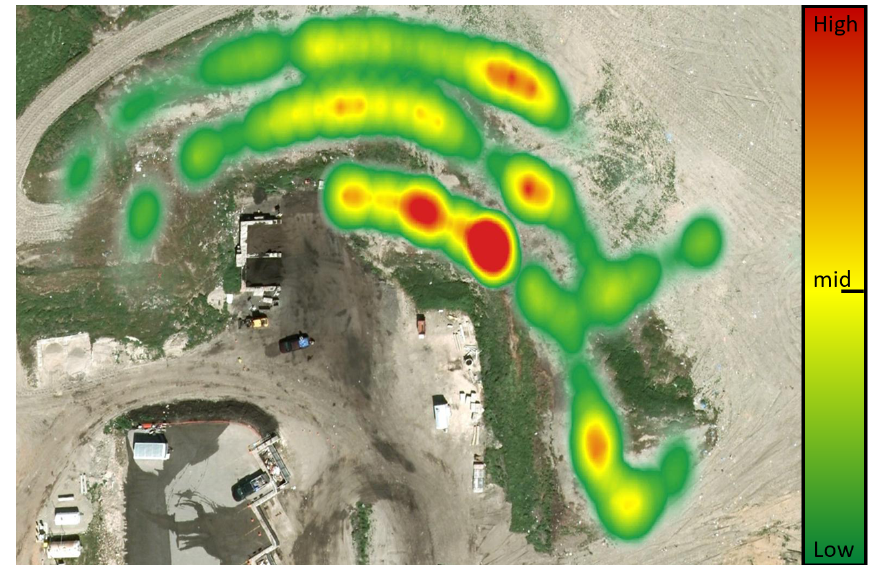
Figure 8. Map showing areas of higher methane